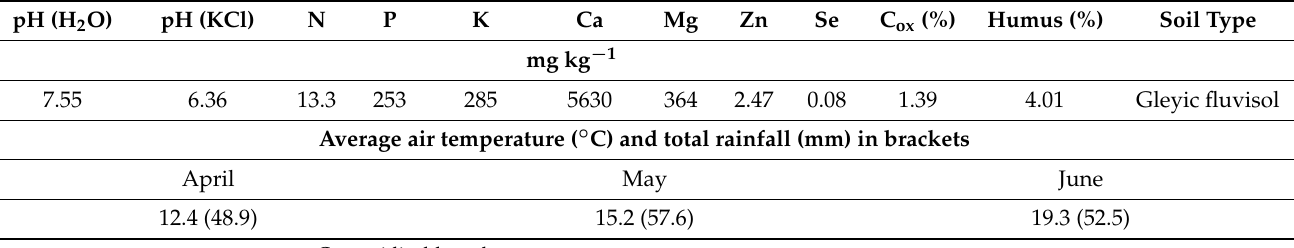
Table 1. Physical and chemical variables of tested soil, mean monthly temperature (air) and total monthly rainfall (April–June) reported in the experimental area in Nitra in